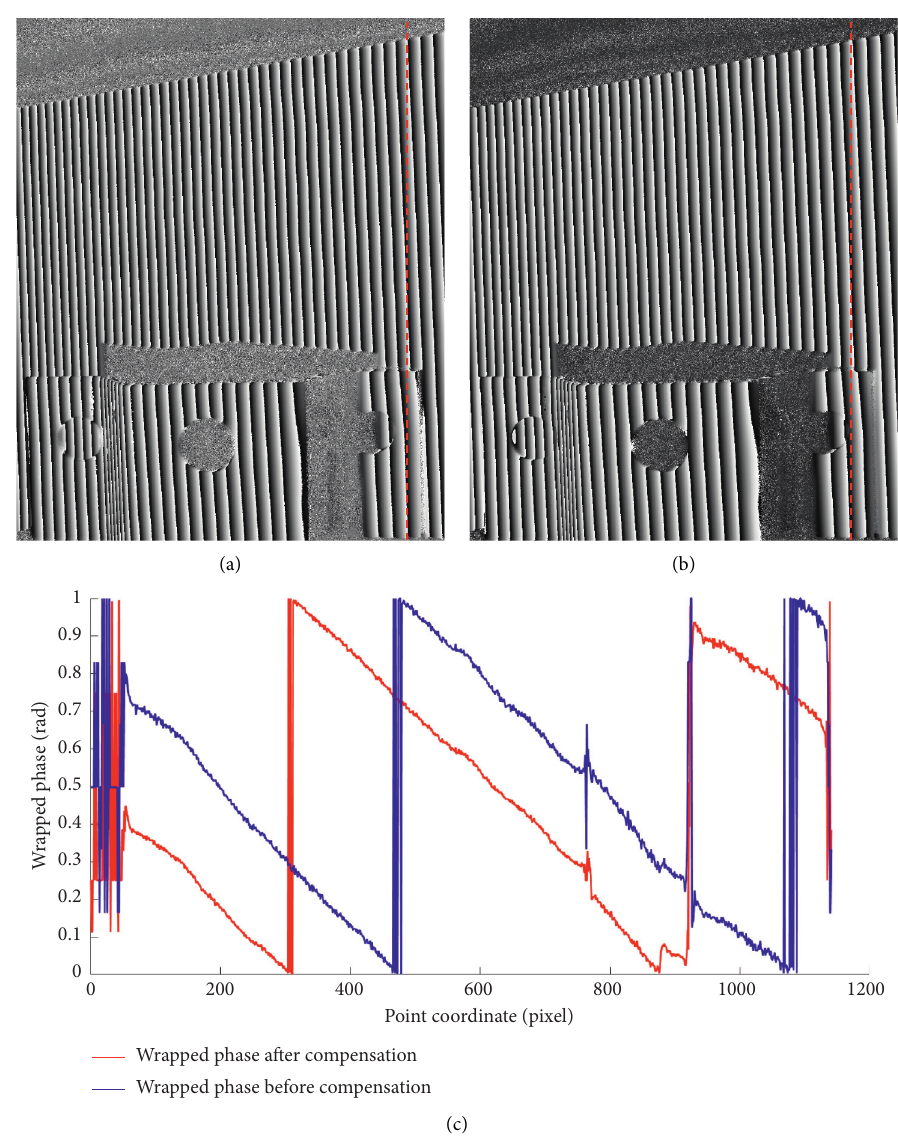
Figure 10: Comparison of wrapped phase error compensation. (a) Our proposed method; (b) three-frequency with four-phase shifts’ method; (c) comparison of wrapped phase measurement errors in 800